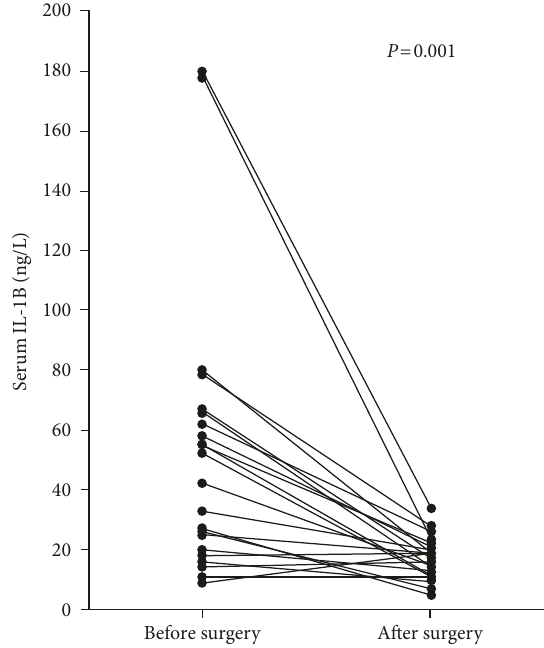
Figure 3: The comparison of serum IL-1B concentrations before and after